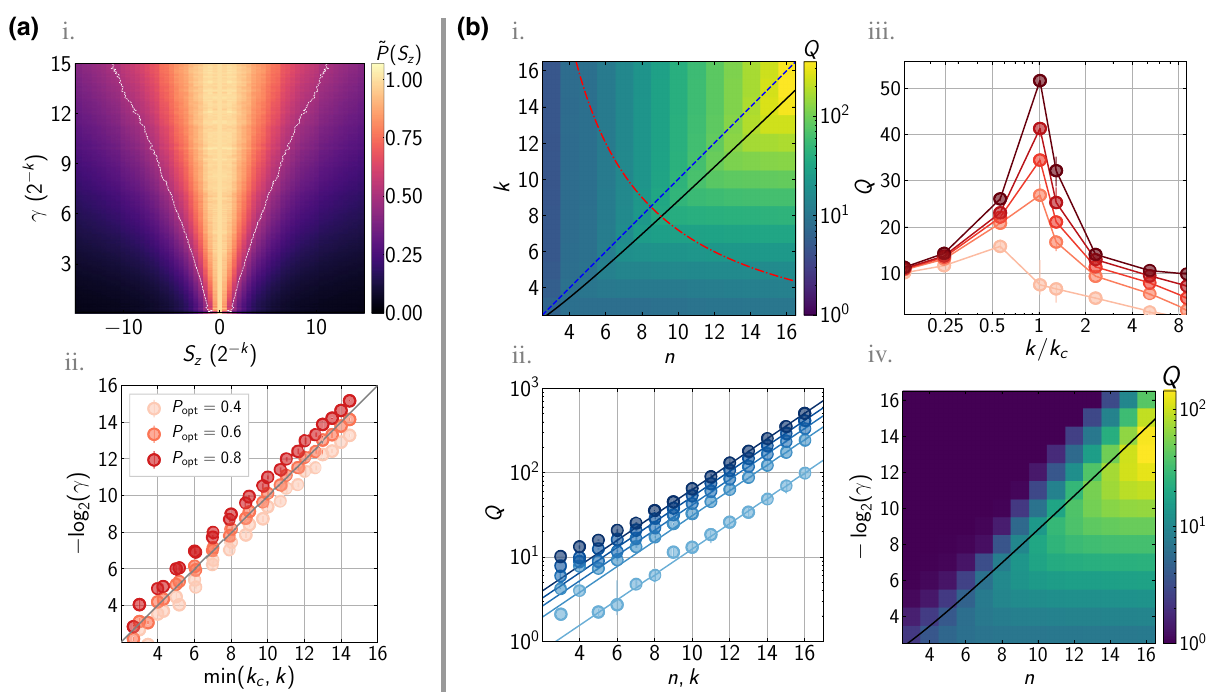
FIG. 4. (a) Step width as capture range. (a.i) Normalized probability distribution ˜ P ( S z ) versus γ , for n = k = 6 with no postselection. White lines indicate contours of ˜ P ( S z ) =0.5. (a.ii) Step width γ required to obtain P opt = [0.4, 0.6, 0.8], shaded from lighter to darker. Results are plotted versus min ( k c , k ) , with markers showing average over all ( n , k ) with 3 ≤ n , k ≤ 16. Gray line shows γ c = 2 − min ( k c , k ) . (b) Quantum speedup in the decision and optimization problems. (b.i) Median speedup [ Q ] at step width γ c . Lines denote k = k c (solid black), k = n (dotted blue), and fixed problem size nk = 72 (dashed red). (b.ii) Cuts of Q along n = k for different quantiles q = [0.01, 0.25, 0.5, 0.75, 0.99], shaded from lightest to darkest. Lines denote Cuts of Q at nk = 72 [red dashed line in (b.i)] for different quantiles, as in (b.ii). Lines are a guide to the eye. (b.iv) Median speedup γ for the optimization problem with machine-precision weights, approximating the large- k limit. [ Q ] versus n and k eff = − log 0.5 2 γ = k Black line shows − log c 2